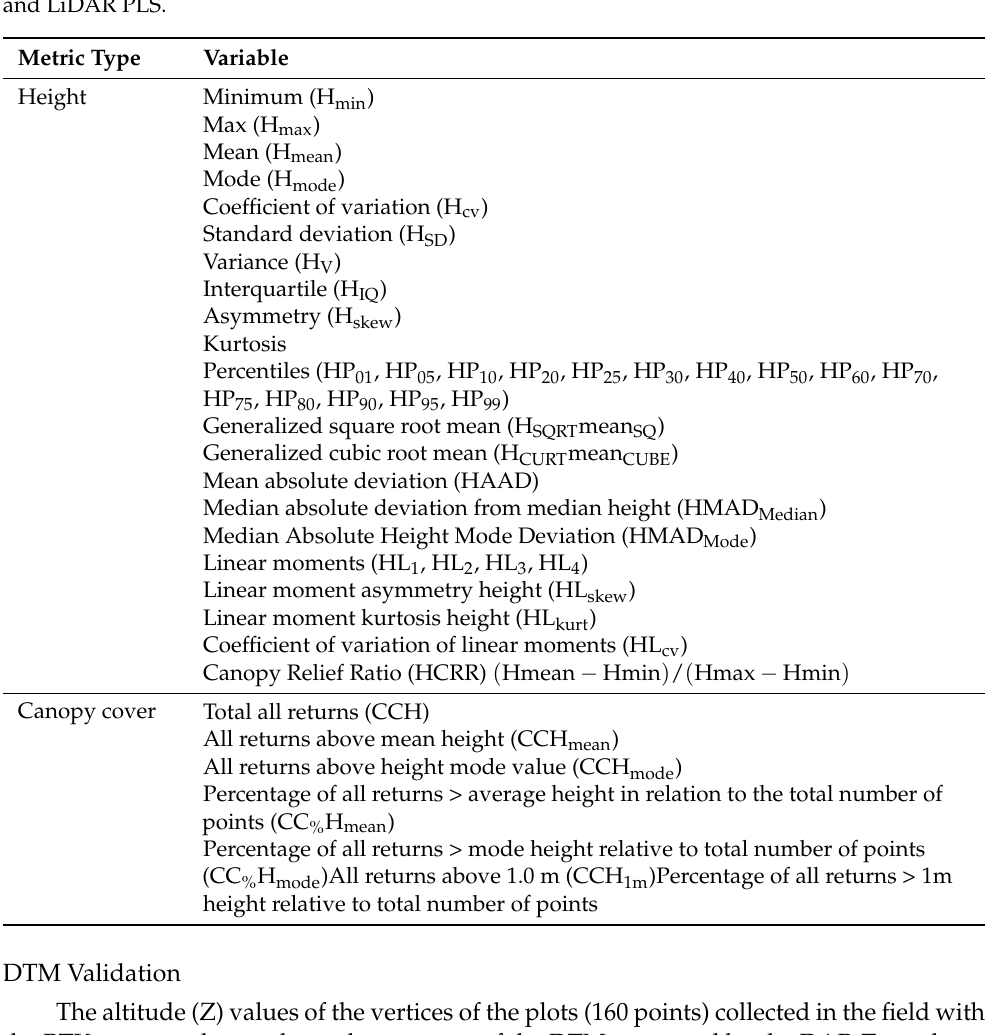
Table 3. Structural metrics extracted from point clouds derived from DAP-UAV, DAP-DTM LiDAR , and LiDAR